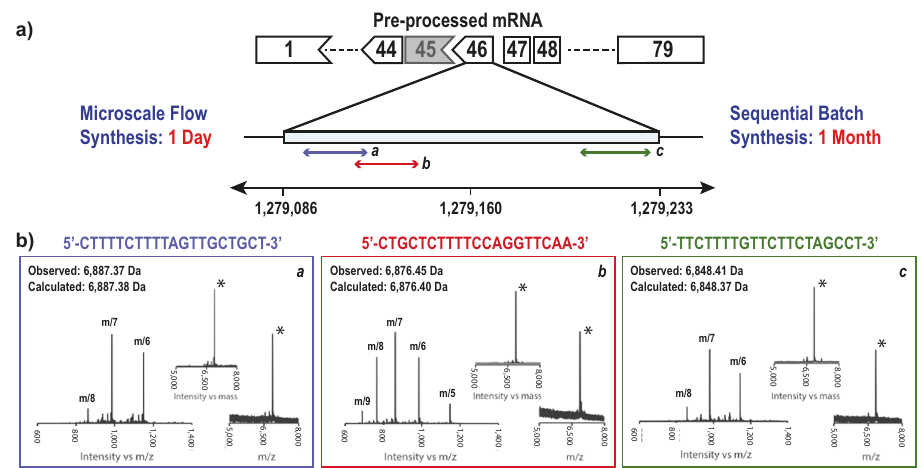
Fig. 5 Automated fl ow synthesis enables the rapid production of antisense PMO candidates to treat DMD. a Gene diagram showing the splicing sites where the three potential therapeutic sequences are targeted. Three sequences were chosen for targeting splice donor and acceptor sites of exon 46. b The mass spectrum, deconvoluted mass spectrum, and MALDI mass spectra of puri fi ed PMOs synthesized in fl ow are shown (see Supplementary section